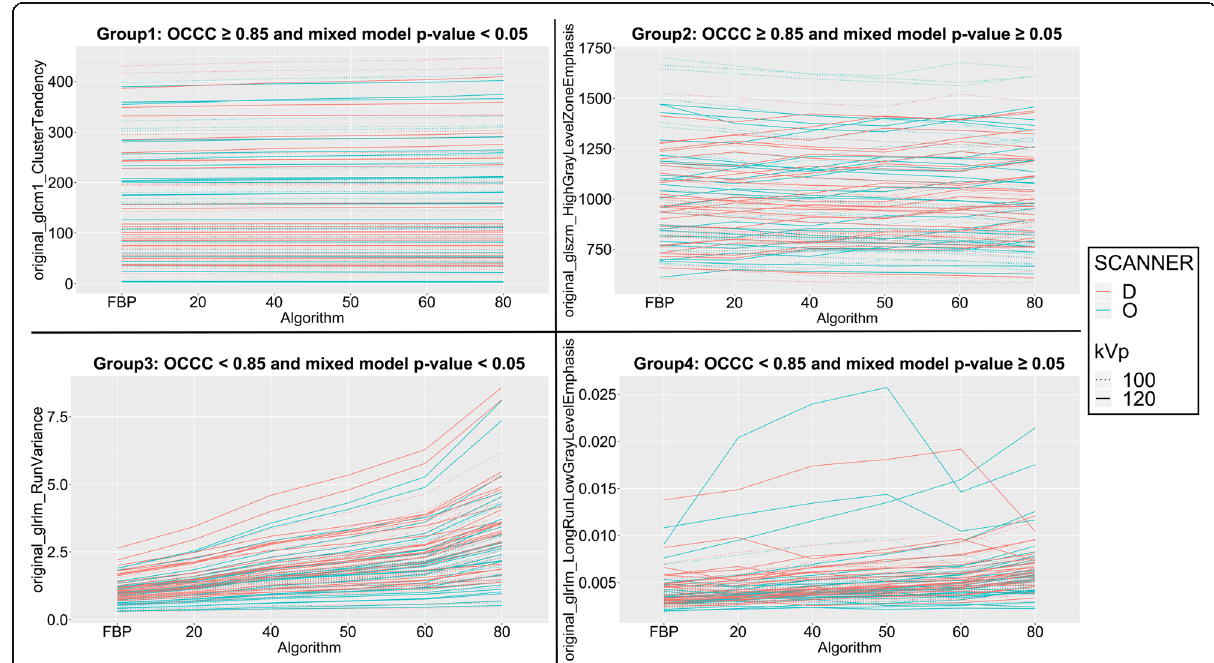
Fig. 3 Feature variation according to reconstruction algorithm, scanner and tube voltage parameters, for all the investigated patients. One feature is selected as representative for each of the four groups of features identified, according to the overall concordance correlation coefficient (OCCC) and multivariable analysis